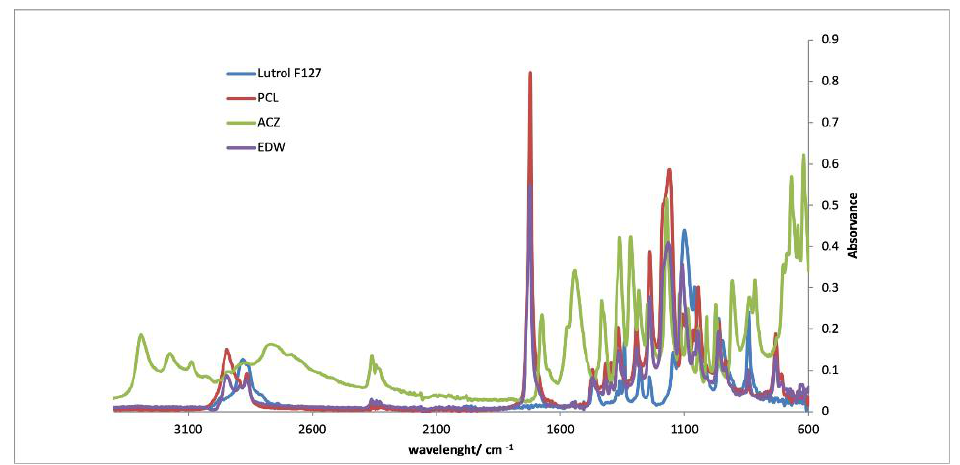
Figure 6. FTIR spectra of EDW implants compared with PCL, Lutrol F127 and acetazolamide.